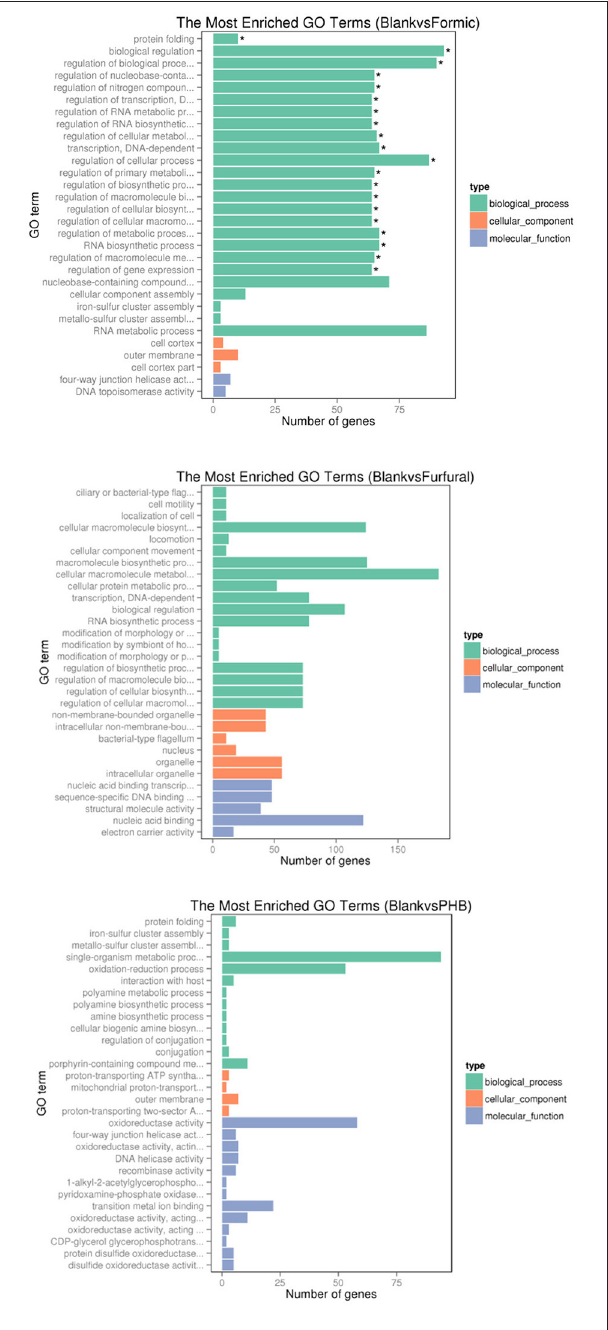
FIGURE 5 | Histogram of the gene ontology classification. The results summarized the three main categories: biological process (BP), cellular component (CC), and molecular function (MF). The X -axis indicates the number of genes in a category. The left Y -axis indicates the second level term of gene ontology. *The significantly